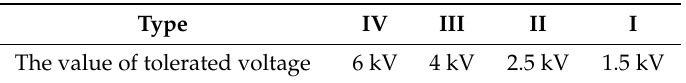
Table 5. The withstand voltage of the device.